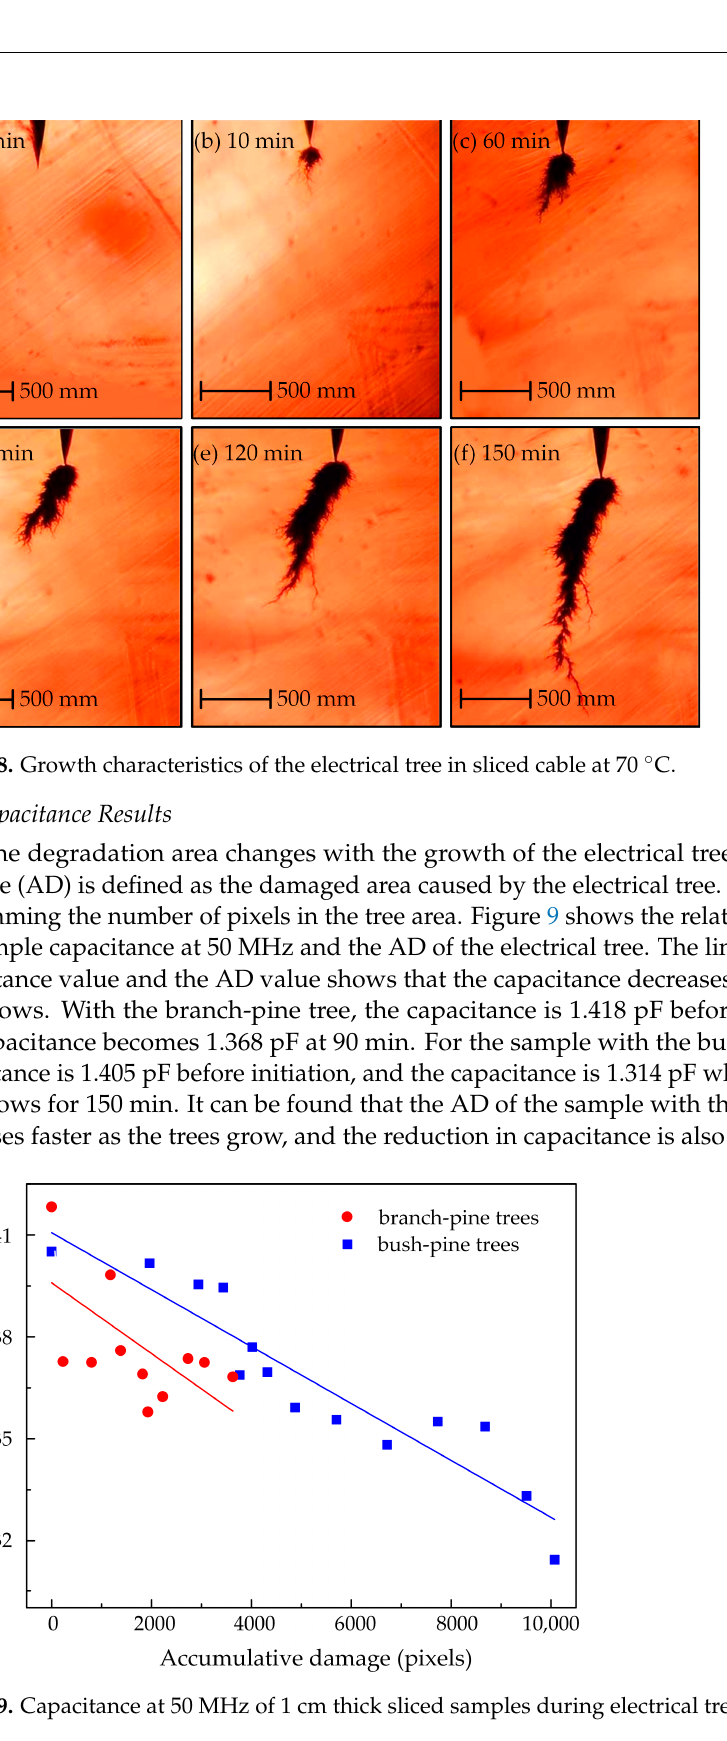
Figure 7. Growth characteristics of the electrical tree in sliced cable at 30 °C.